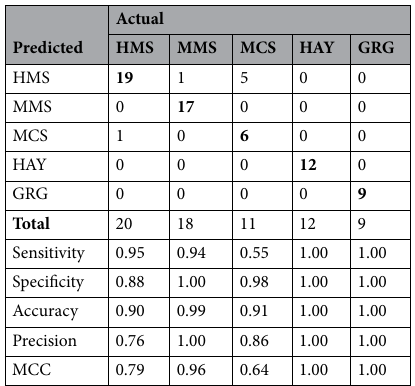
Table 4. Descriptive statistics of the cross-validation based on the leave-one-out criteria of the factorial discriminant analysis (FDA). HMS, high maize silage; HMS , high maize silage; MMS , medium maize silage; MCS , mixed crop silages; HAY , grass and lucerne hays; GRG , green grass; MCC = Matthews correlation coefficient. Bold values represent the samples classified correctly.